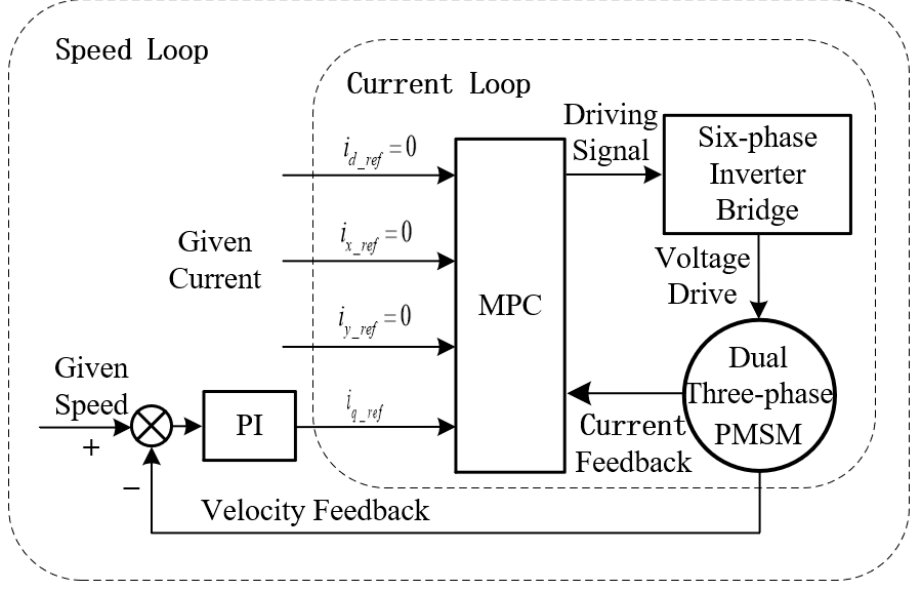
Figure 2. A conventional dual three-phase PMSM drive